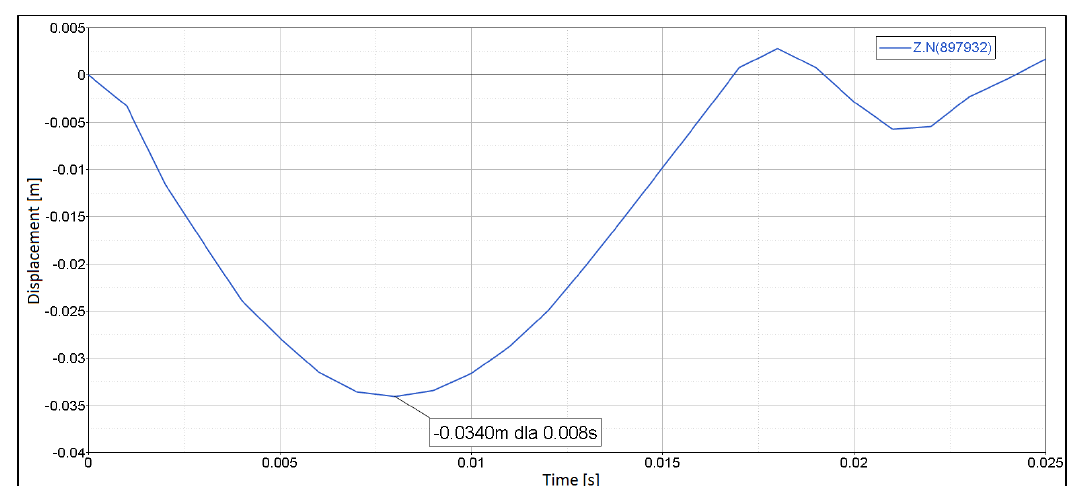
Figure 7. Maximum windscreen strain — temp. = − 30 °C ( t = 8 ms) .